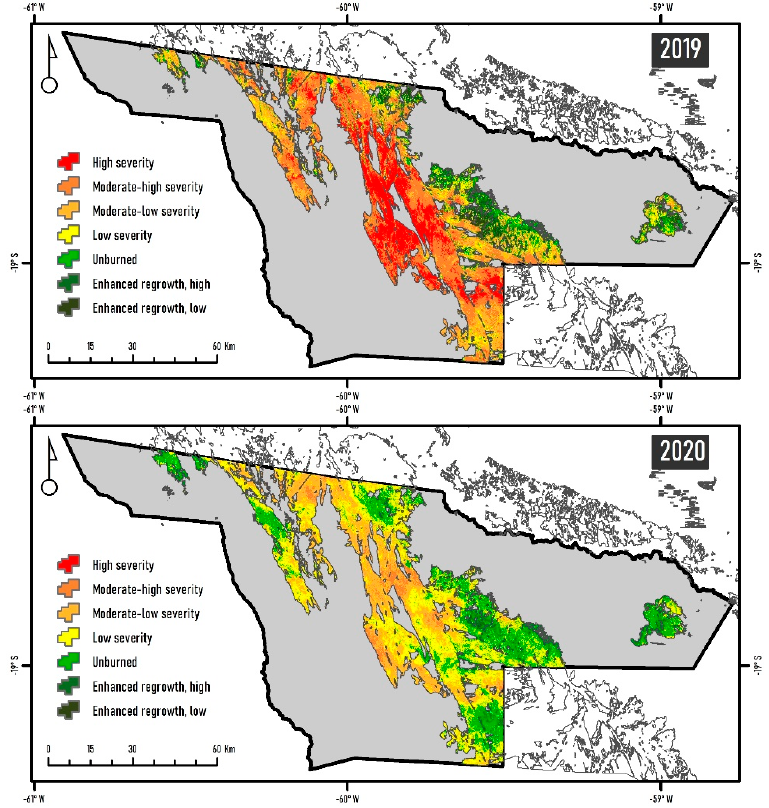
Figure 8. Fire severity levels based on dNBR at Ñembi Guasu between 2019 and 2020.